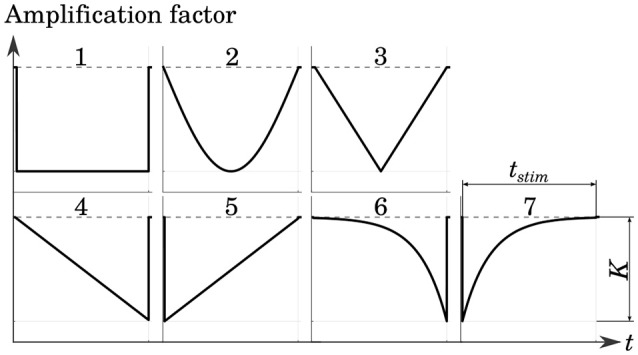
Tested cathodic stimulation waveform shapes: rectangular (1), sinusoidal (2), centered triangular (3), linearly increasing (4) and decreasing (5), exponentially increasing (6) and decreasing (7). All but the centered triangular waveform were adopted from Sahin and Tie (2007). Stimulus phase duration tstim and amplitude K were varied in the simulations.